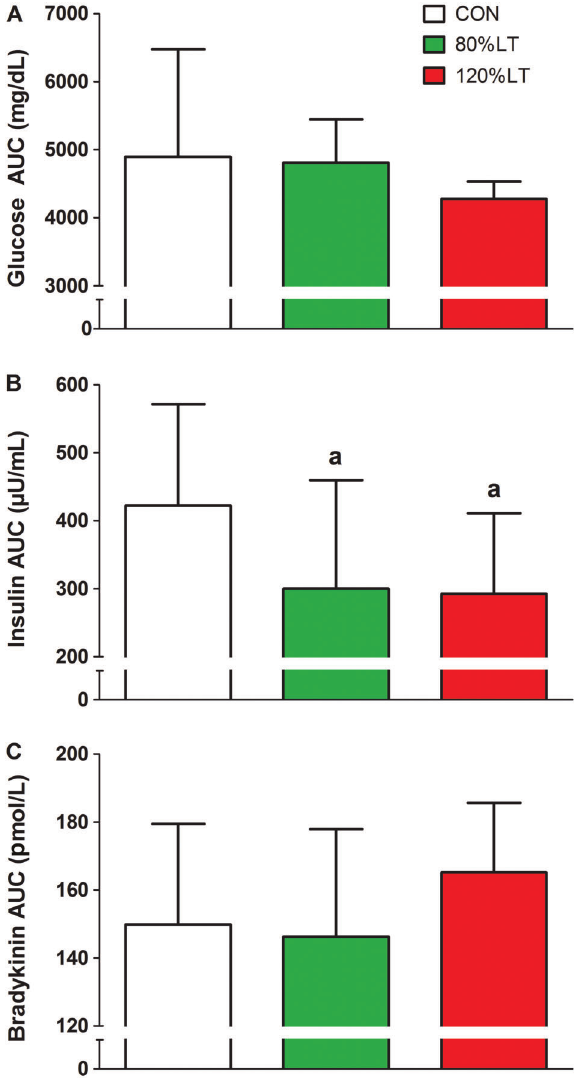
Figure 3. Area under the curve (AUC) of blood glucose ( A ), insulin ( B ), and bradykinin ( C ) after the CON, 80%LT, and 120% LT sessions. Data are reported as means ± SD. CON: control condition; 80%LT: exercise at 80% of lactate threshold; 120%LT: exercise at 120% of lactate threshold. a P o 0.05 compared to CON (repeated measures ANOVA).